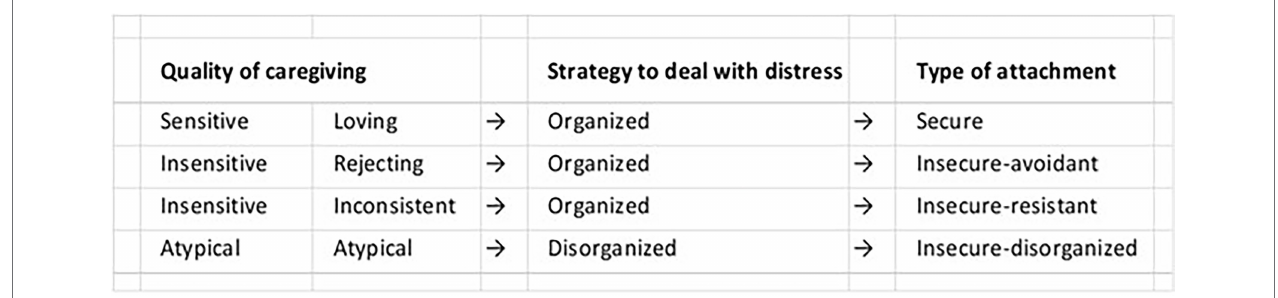
FIGURE 9 | Attachment Types . According to Bowlby’s attachment theory, infant behavior is self-regulated by conscious brain mechanisms. Behavioral disorders are identified according to four attachment types or